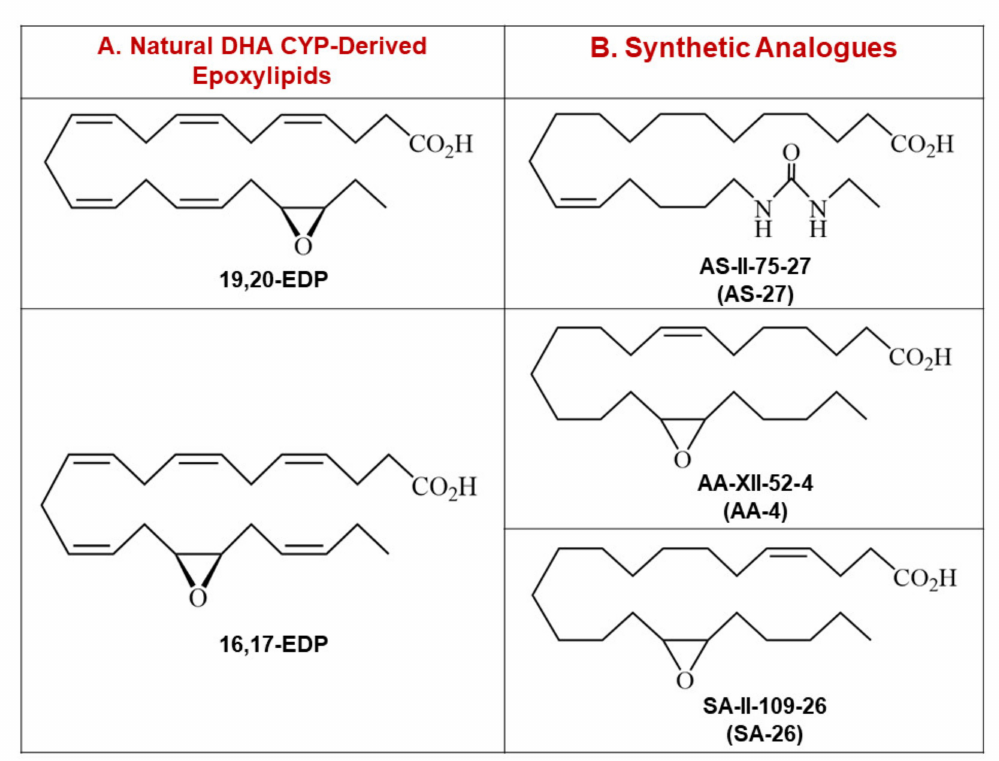
Figure 1. ( A ) Chemical structures of the two most abundant natural metabolites of DHA, 19,20-EDP and 16,17-EDP. ( B ) Chemical structures of AS-27, the synthetic analogue of 19,20-EDP, as well as AA-4 and SA-26, synthetic analogues of 16,17-EDP. DHA: Docosahexaenoic acid, EDP: Epoxydocosapentaenoic